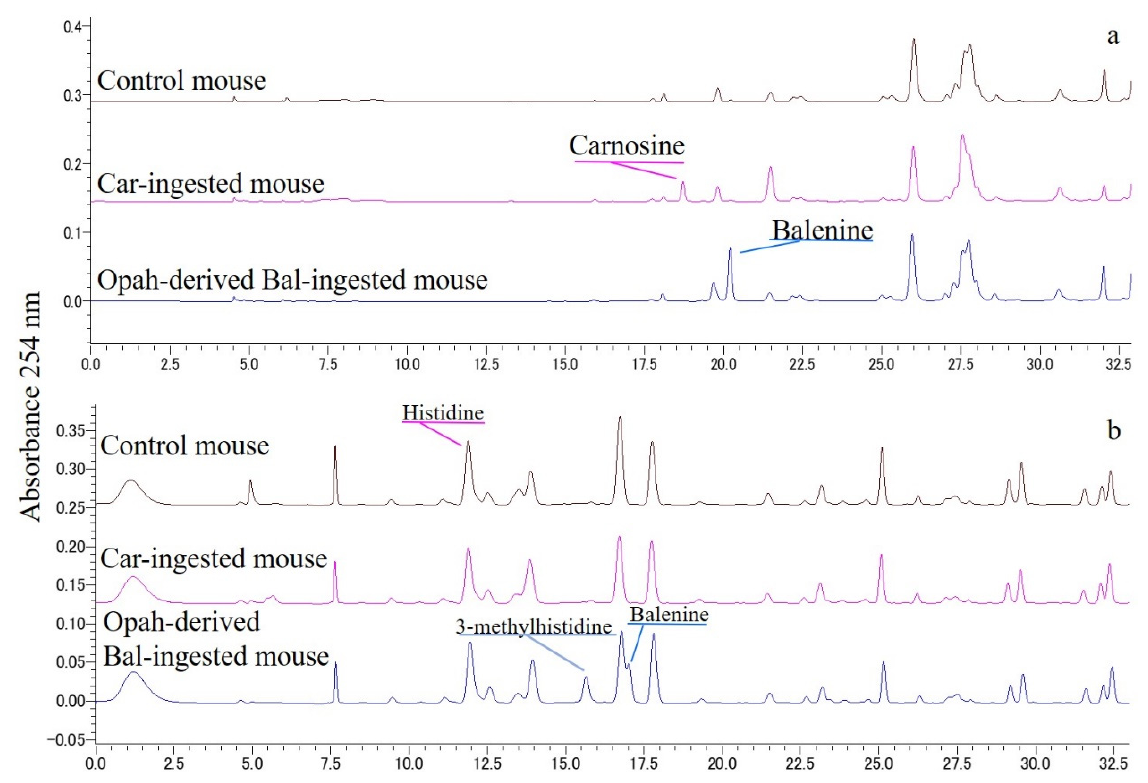
Figure 5. HPLC chromatogram of PITC-derivatized mouse plasma after administration of water (control), carnosine (Car-administrated mouse), and opah-derived balenine (opah-derived Bal-administrated mouse). The chromatogram upper column ( a ) shows detection of carnosine and balenine from mouse plasma 1 h after administration. The chromatogram upper column ( b ) shows the detection of histidine and 3-methylhistidine in mouse plasma 1 h after administration.